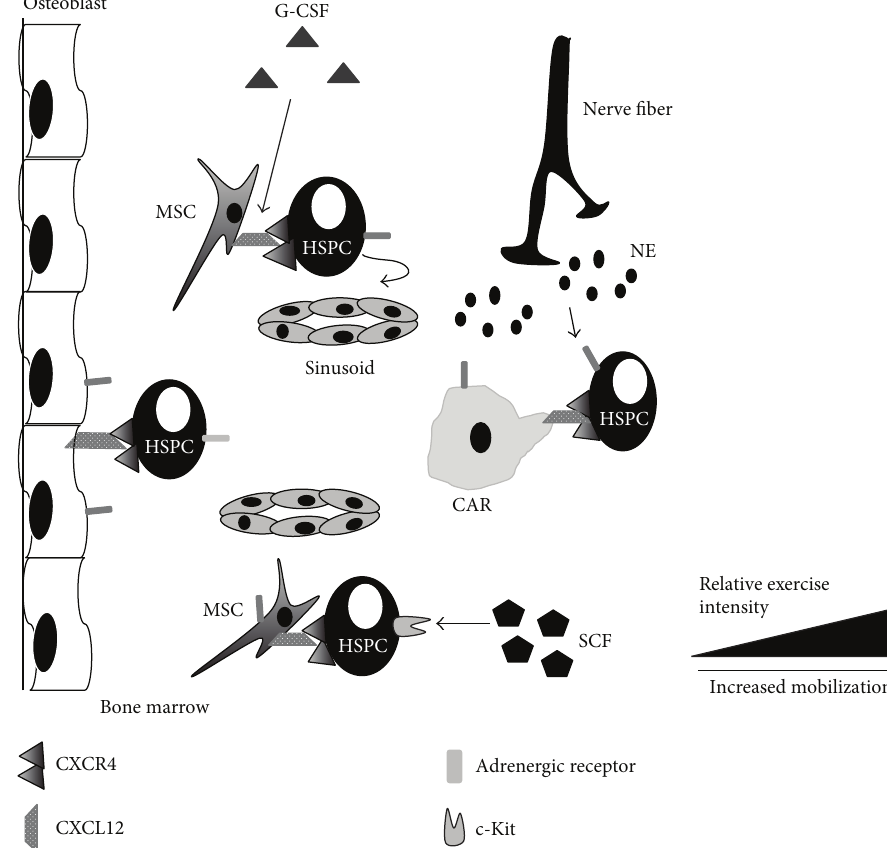
Figure 1: Acute exercise mobilizes hematopoietic stem and progenitors into peripheral circulation from the bone marrow niche. HSPCs receive signals from a variety of cell types including osteoblasts, mesenchymal stromal cells (MSCs), CXCL12-abundant reticular (CAR) cells, and mature hematopoietic cells throughout the bone marrow. Paracrine factors secreted by stromal cells, such as stem cell factor (SCF) or granulocyte colony stimulating factor (G-CSF), or norepinephrine by nerve fibers act to free HSPCs for entrance into peripheral circulation via sinusoidal openings. The magnitude of HSPC mobilization and paracrine factor release is increased with higher exercise intensity relative to the individual’s VO 2